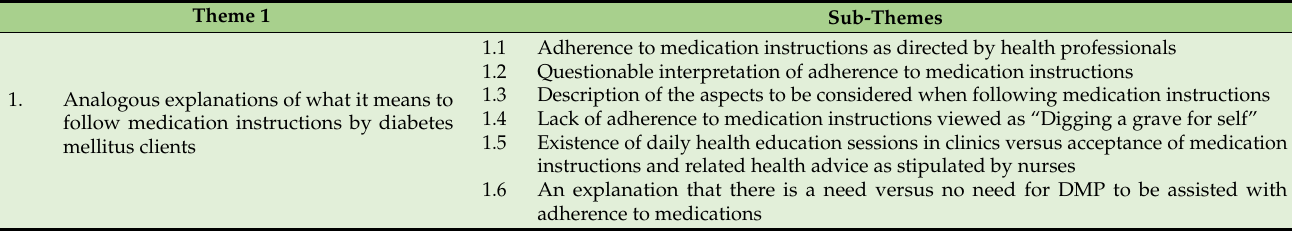
Table 2. Analogous explanations of what it means to follow medication instructions by diabetes